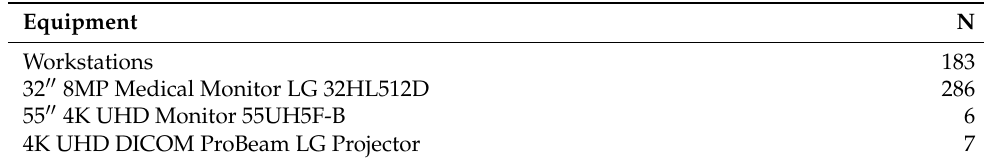
Table 3. Workstation and monitor deployment.